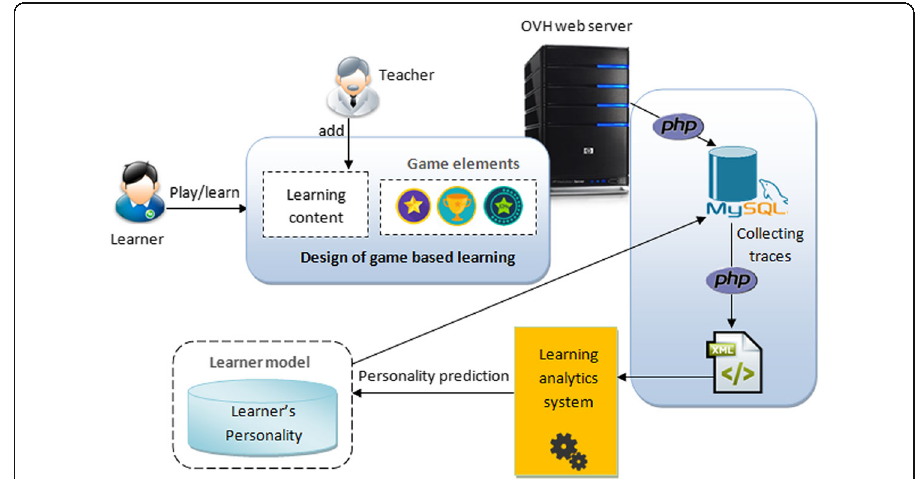
Fig. 1 The proposed framework to model the learner ’ s